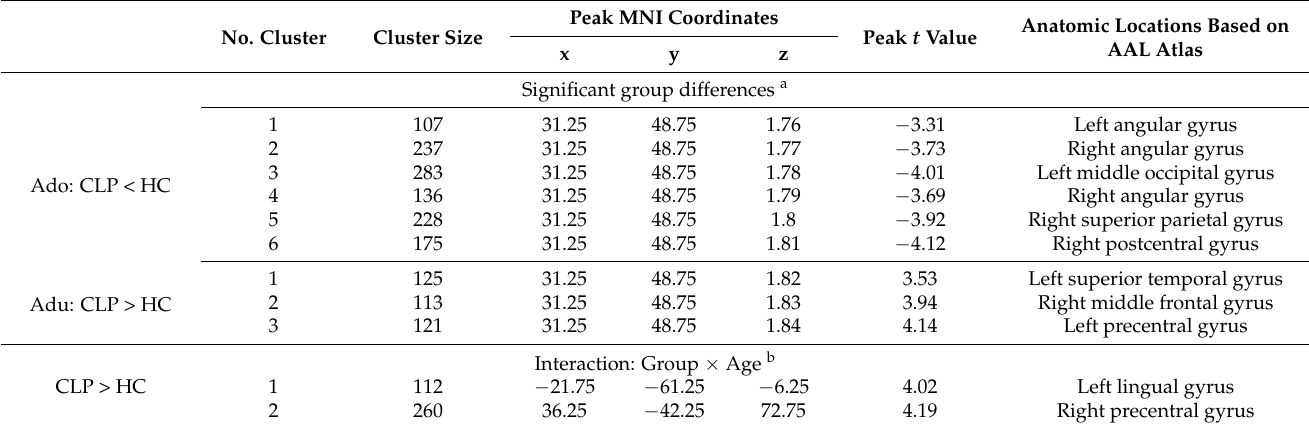
Table 2. Group differences in gray matter (GM) intensity based on volume-based morphometry analyses.